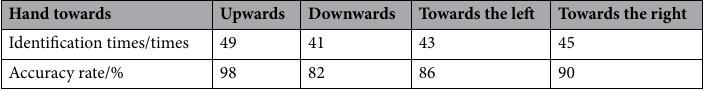
Table 1. Grasping gesture recognition rate in four cases.